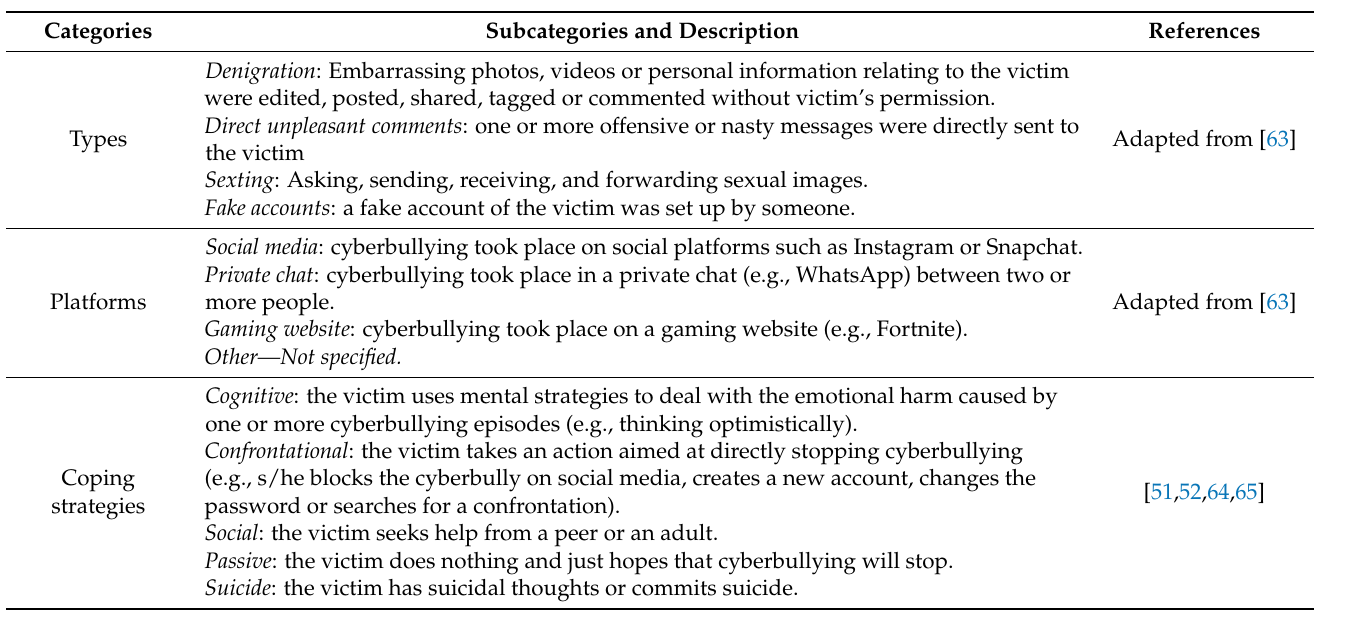
Table 2. Coding system of cyberbullying episodes and coping